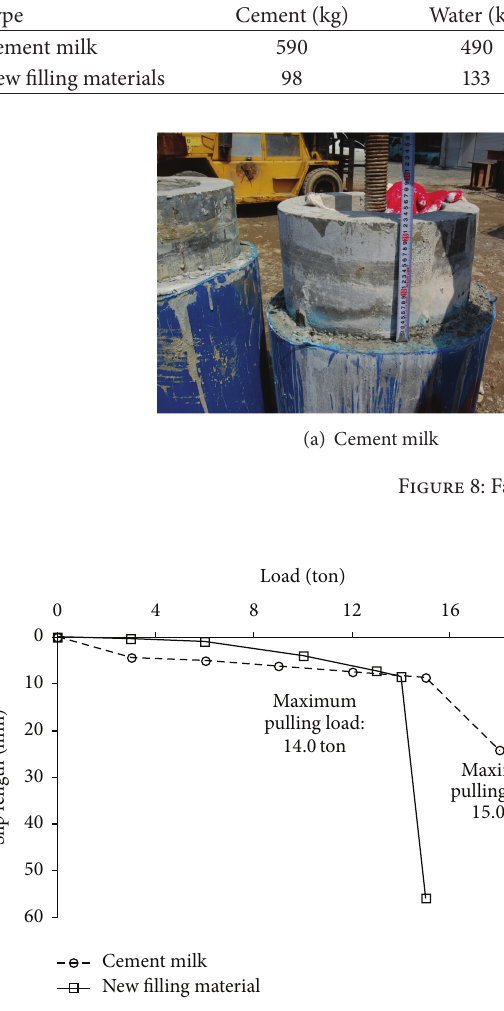
Figure 9: Bond capacity result from the pull-out